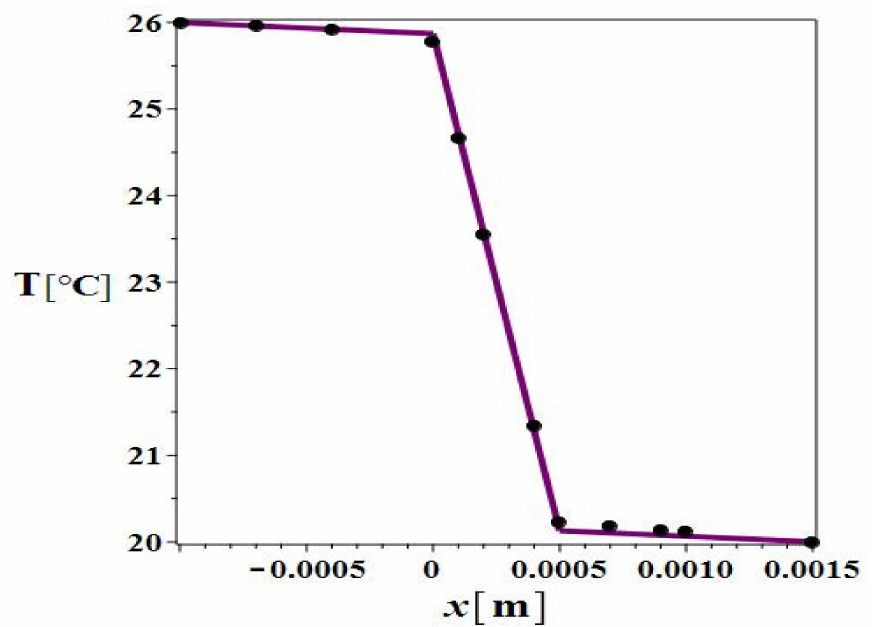
Figure 4. Temperature variation as a function of x for y = 15 mm in the TGC which is maintained at T h = 26 ◦ C, T c = 20 ◦ C and containing the binary fluid toluene–methanol. Numerical calculations are shown by black dots and analytical results are given by red line.